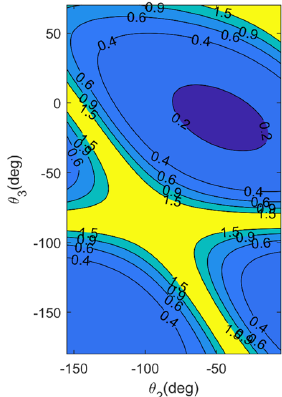
Figure 9. Contour map of ω − 1 under the two